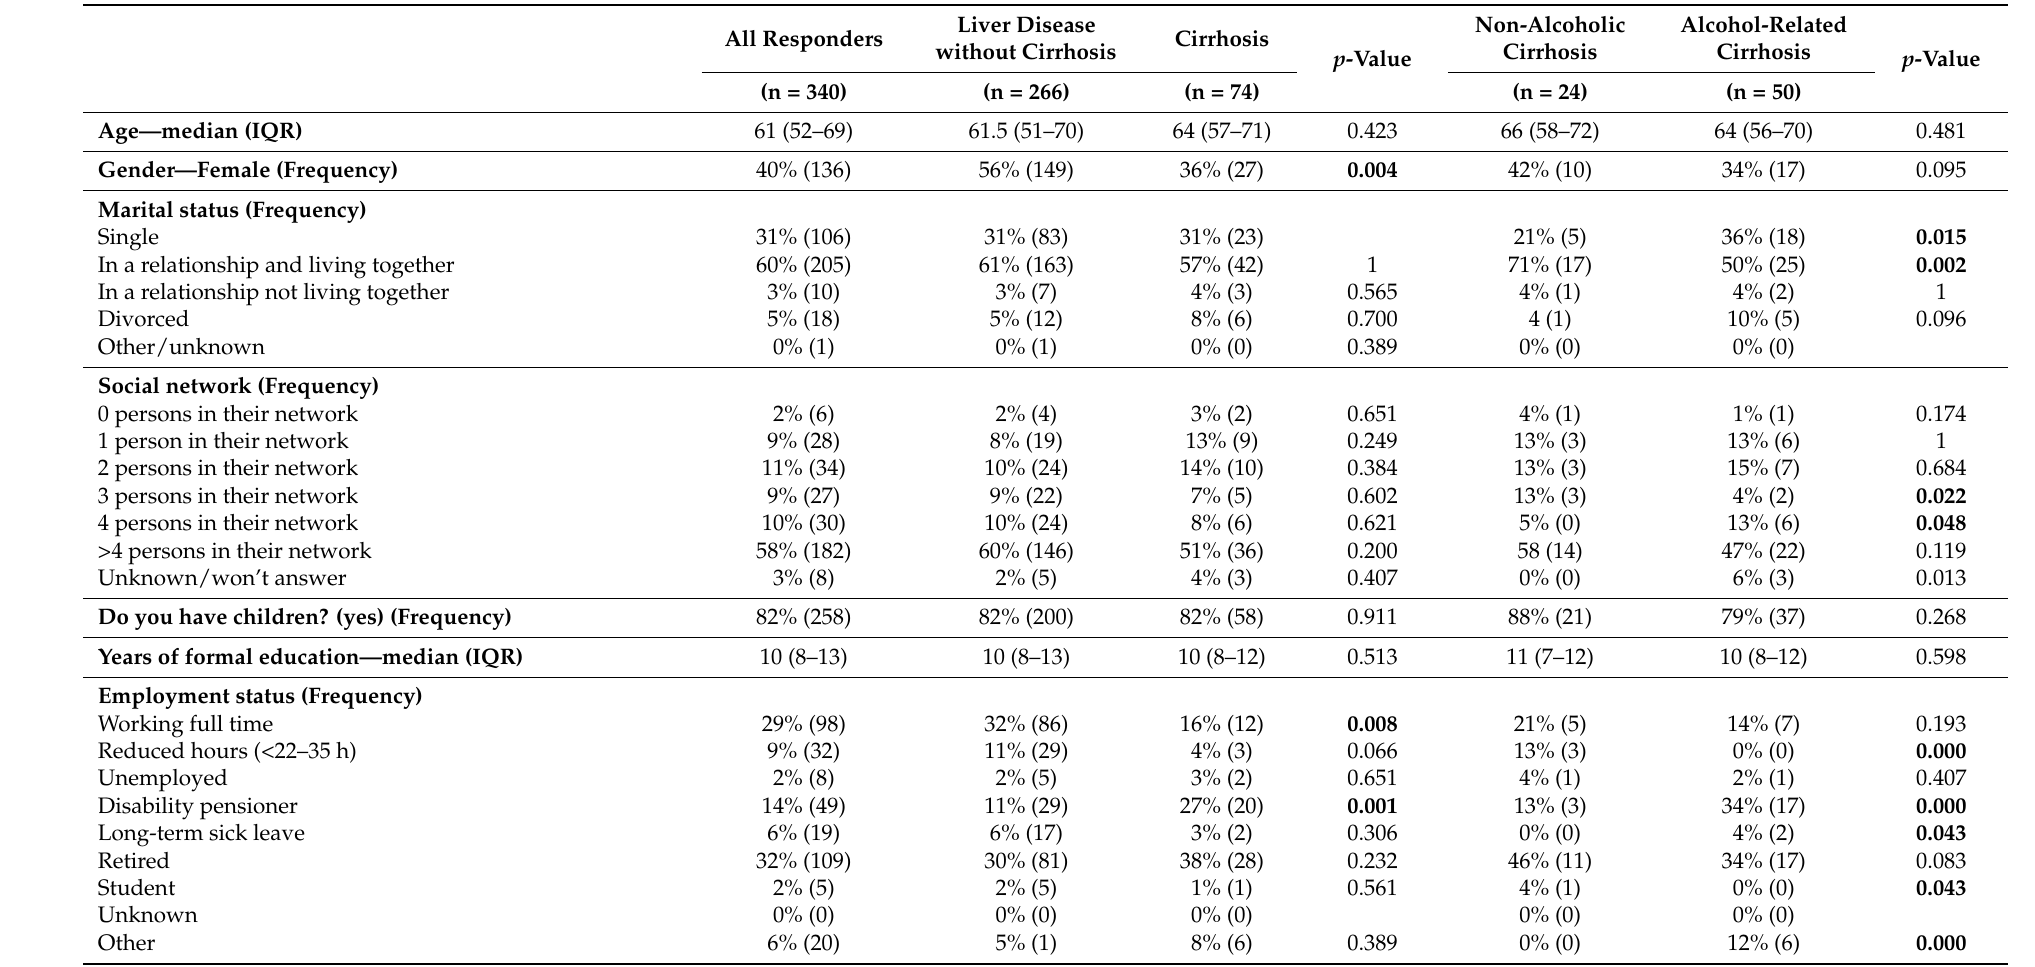
Table 2. Baseline characteristics of all